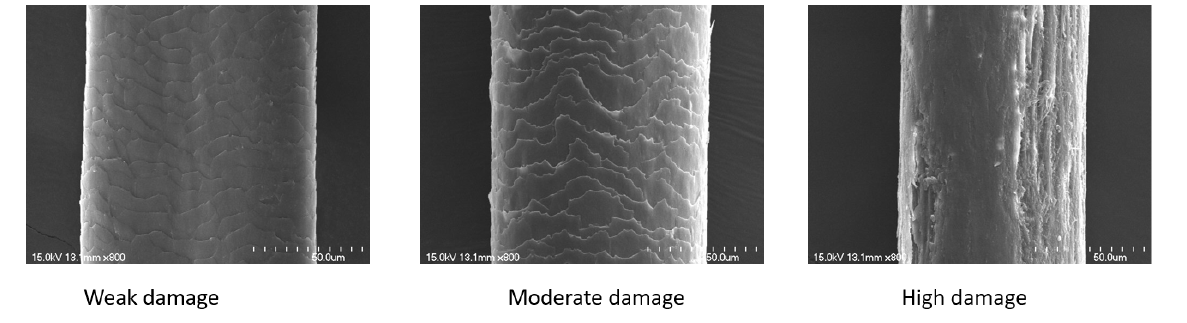
Figure 7. Classification of hair damage.